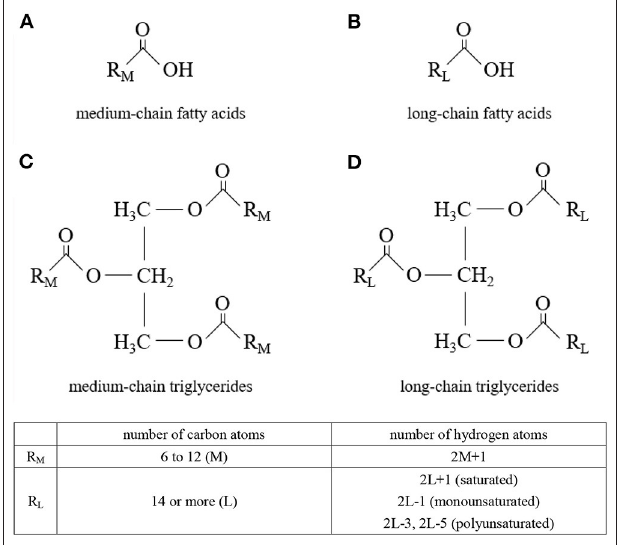
FIGURE 1 | Molecular structures. (A) medium-chain fatty acids, (B) long-chain fatty acids, (C) medium-chain triglycerides, and (D) long-chain triglycerides.